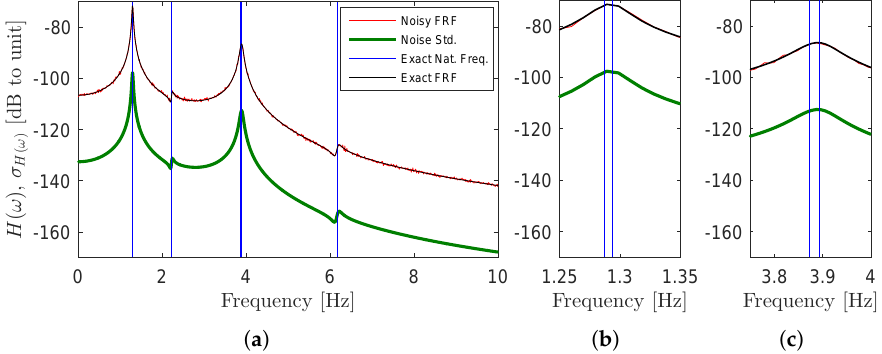
Figure 14. Element(1,1) of the FRF matrix contaminated with 5% noise: exact and noisy FRF, noise standard deviation and exact natural frequencies (vertical lines) ( a ); and details of the close spaced modes around 1.29 Hz ( a ) and 3.88 Hz ( b ).